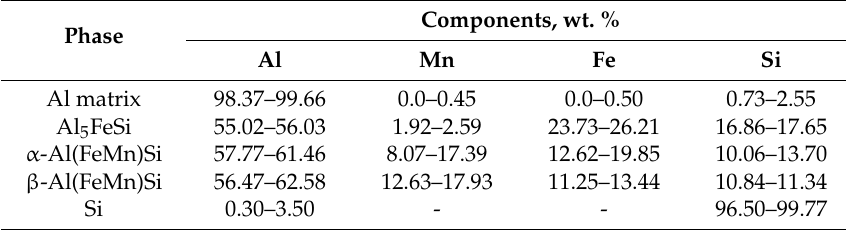
Table 5. Composition of detected precipitated phases in all investigated alloys. Figure 7. Composition change in the Al(FeMn)Si phase with increasing Mn content in the alloy group AlSi8Fe1.5–Mn.